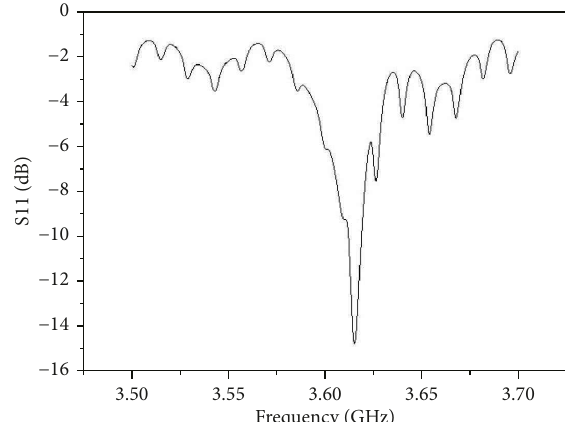
Figure 8: Te resonance frequency fgure of the AlN-based FBAR sensor before adding acetone, the horizontal axis is frequency while the vertical axis is S 11 parameter.